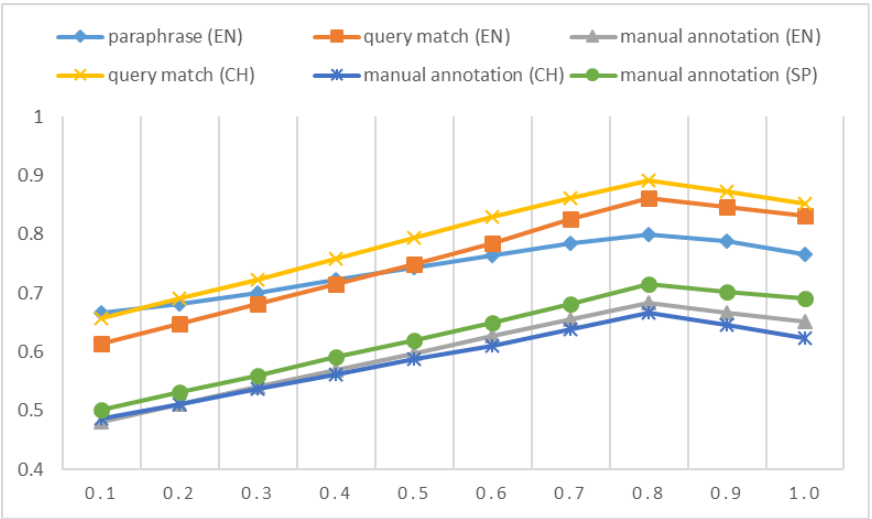
Figure 5. F1 values when we change the threshold from 0.1 to 1.0. The threshold is utilized to de- cide whether to connect two triggers in the event connection graph or